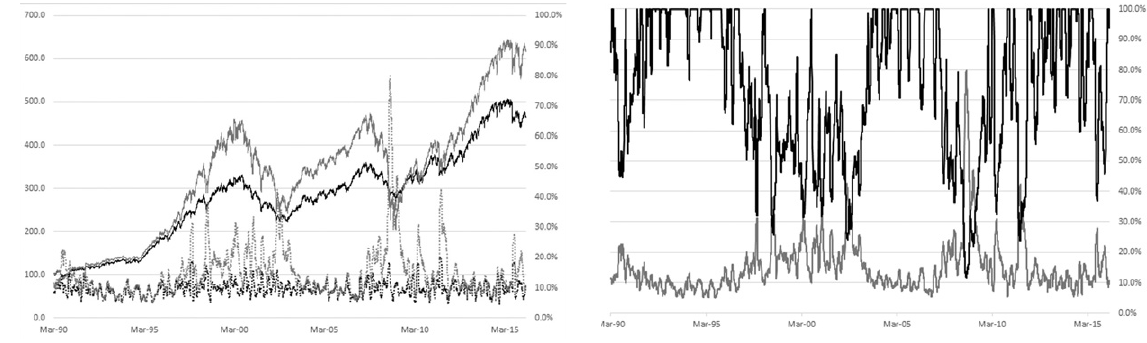
Figure 1. Comparative results for the TVS STD portfolio and the S&P 500 Note: The left side presents the path of TVS STD (solid black line) and of S&P 500 (solid gray line), and the TVS STD rolling standard deviation (dotted black line) and the S&P rolling standard deviation (dotted gray line). The right side presents how the equity exposure of the TVS STD (solid black line) changes with respect to the volatility of the S&P 500 (solid gray line).